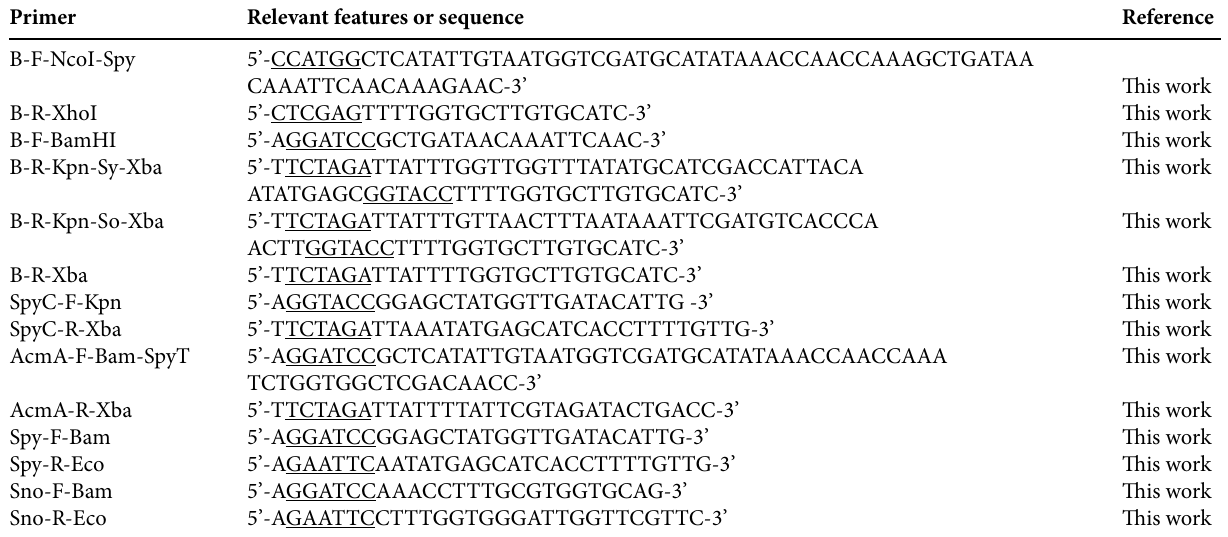
Table 3. Primers used in this study Primer Relevant features or